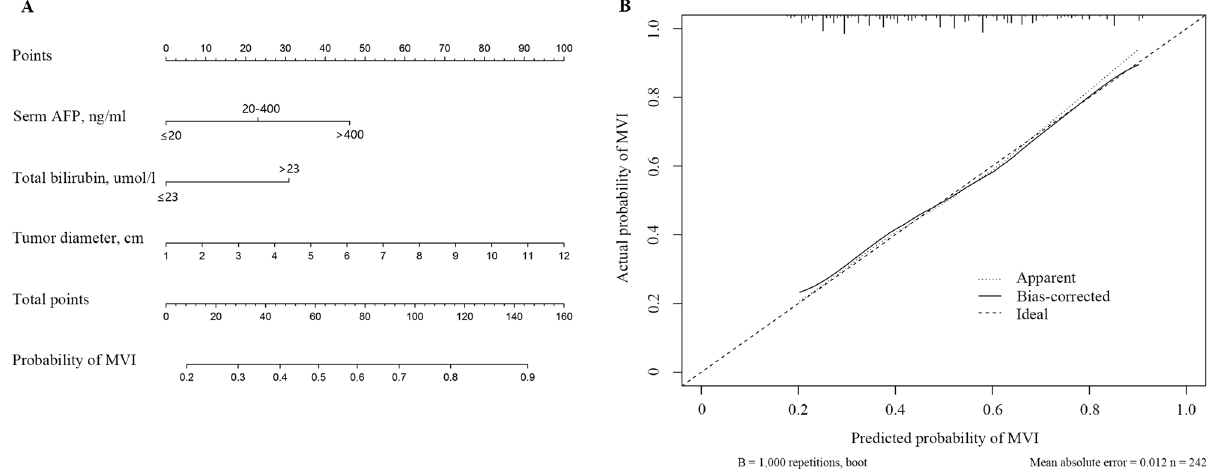
Figure 3. Developed diagnosis nomogram for microvascular invasion prediction. ( A ) A vertical line was drown upward to find the number of points received for AFP, tumor diameter and TB. The sum of three influencing factors was presented on the total point axis, and a vertical line was also drawn downward to the the probability of MVI. ( B ) The calibration curves of nomogram model prediction in HCC patients. The X-axis showed the predicted probability of MVI. The Y-axis showed the actual probability of MVI. The solid line indicated the performance of the developed nomogram